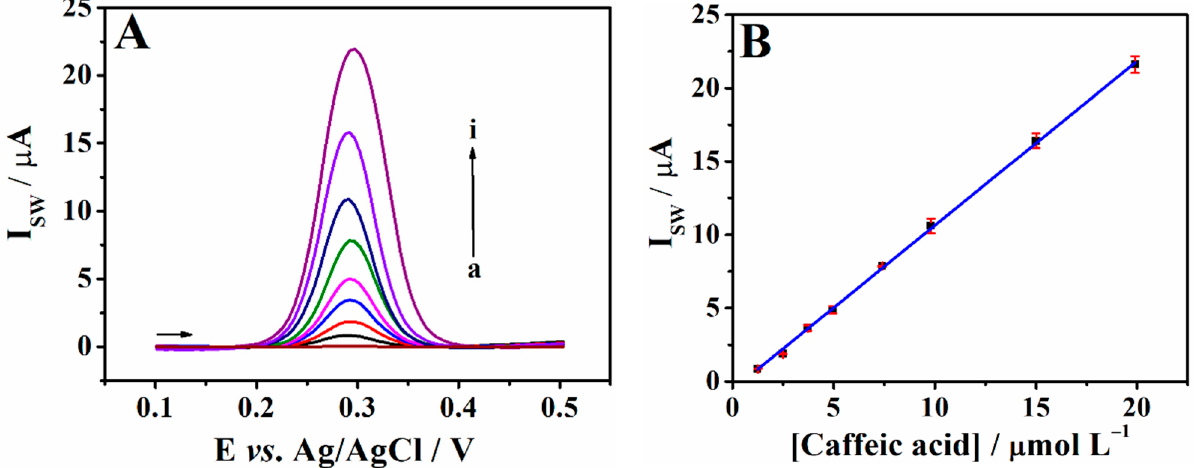
Figure 4. ( A ) Square wave voltammograms for different concentrations of caffeic acid in 0.1 mol L − 1 acetate buffer (pH 5.0) at the PEI/CPE: (a) blank, (b) 1.25, (c) 2.49, (d) 3.72, (e) 4.95, (f) 7.39, (g) 9.80, (h) 15.0, and (i) 19.9 μ mol L − 1 . ( B ) Calibration plot for caffeic acid ( n = 3). SWV parameters: a = 70 mV, f = 30 Hz and Δ Es = 3 mV.